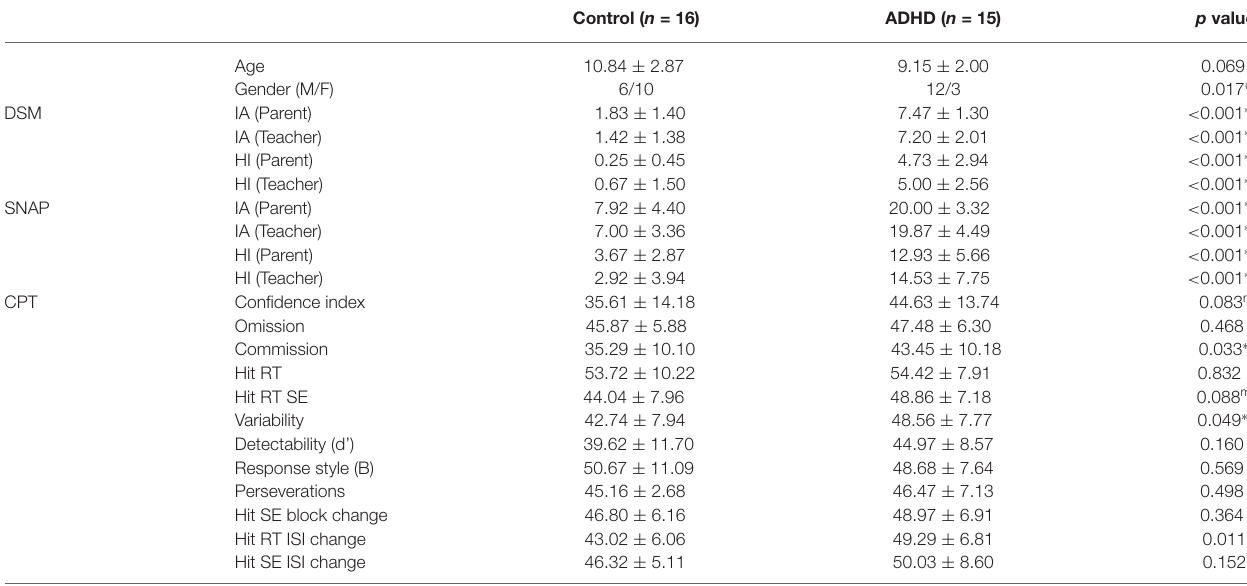
TABLE 1 | Demographic characteristics, ADHD symptom scores, and continuous performance test between the control and ADHD